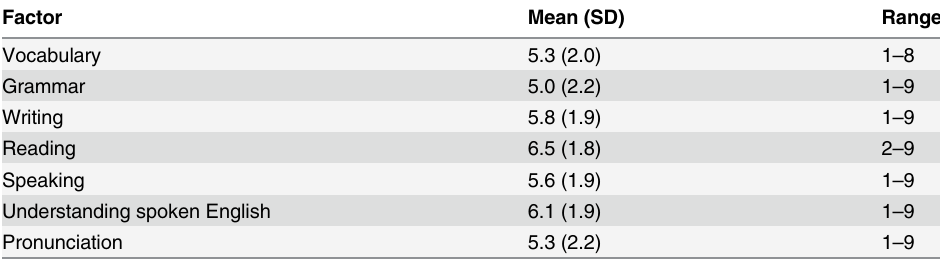
Table 1. L2 self-rating (from 0 "none" to 10